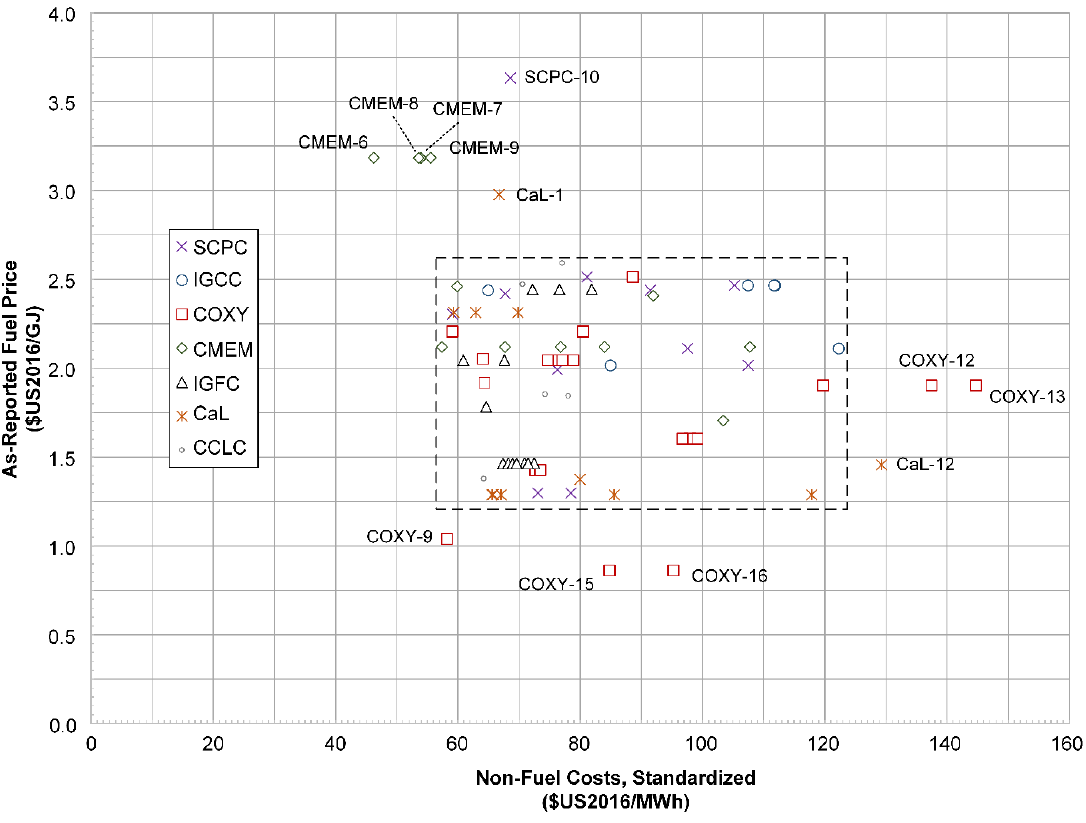
Figure 11. Scatter plot of fuel unit prices and non-fuel costs for coal-based systems as reported by each study and then converted to $US2016 according to the methods of Section 2. COXY = coal-based oxyfuels, CMEM = coal-based membranes, IGFC = integrated gasification (solid oxide) fuel cell, CaL = calcium looping capture, and CCLC = coal-based chemical looping combustion. The dashed line identifies the “typical” range of the data set as a visual aid only. Note that all plants in the above plot are CCS ‐ enabled.